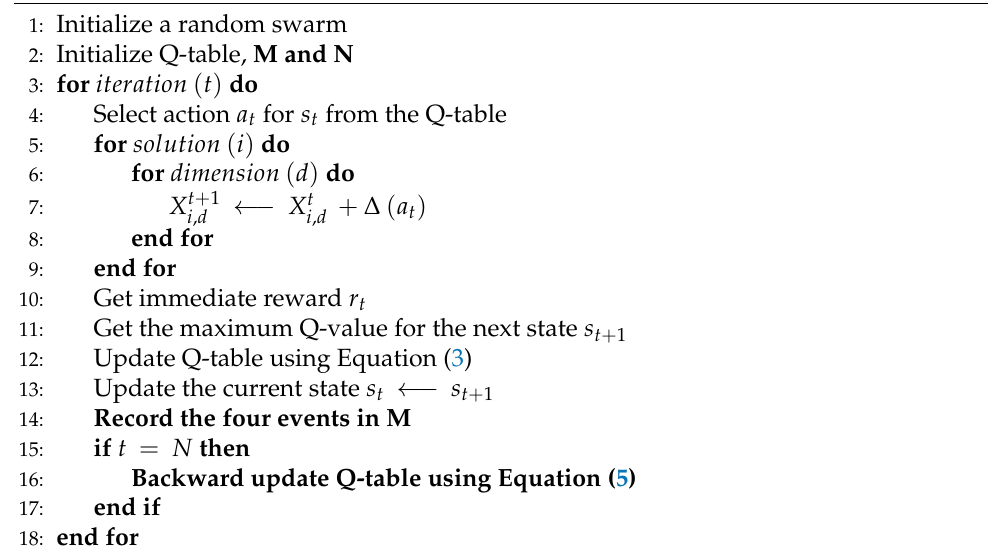
Algorithm 6 Binarization scheme selector modified.